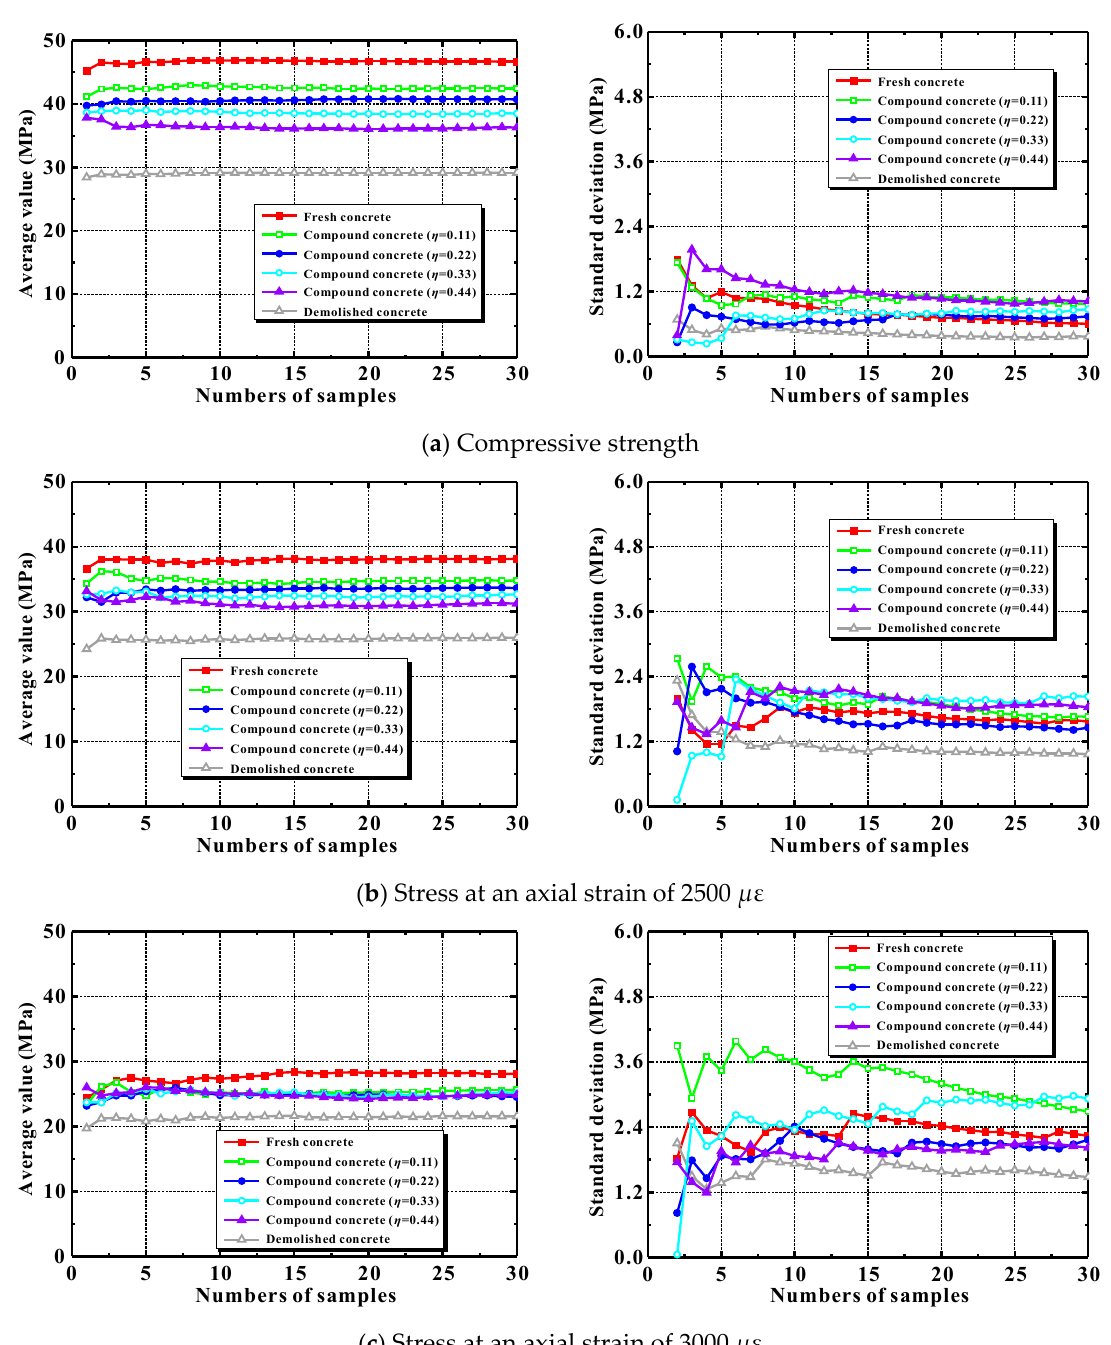
Figure 11. Mean stresses and their standard